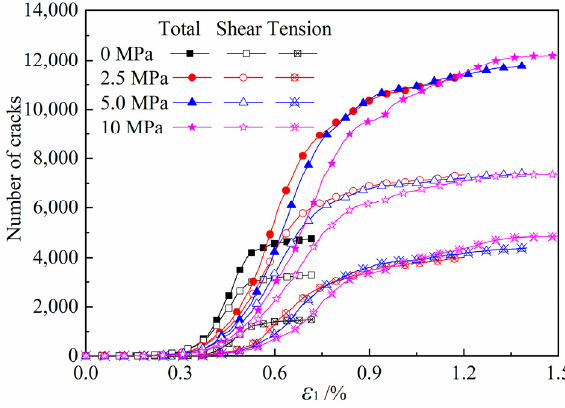
Figure 17. Growth process of crack number in RAC8009 under different confining pressures.